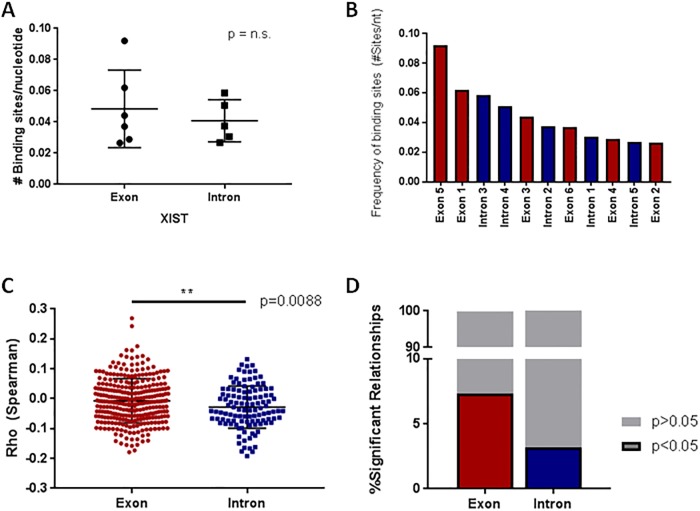
miRNAs exonically-bound to XIST exhibit increased relationships with DMX genes.A) The number of miRNA binding sites on XIST is not enriched when introns and exons are compared. B) Number of miRNA binding sites on the introns and exons of XIST; exon 5 has the greatest concentration of miRNA binding sites. C) miRNAs bound to XIST exclusively on exons exhibit stronger miRNA-DMX Spearman’s correlation values. D) Similarly, a larger proportion of correlations between miRNA-DMX pairs are significant when the miRNA binds to an exonic (vs. intronic) region of XIST. In this Fig, exons are depected in red, while introns are depicted in blue.